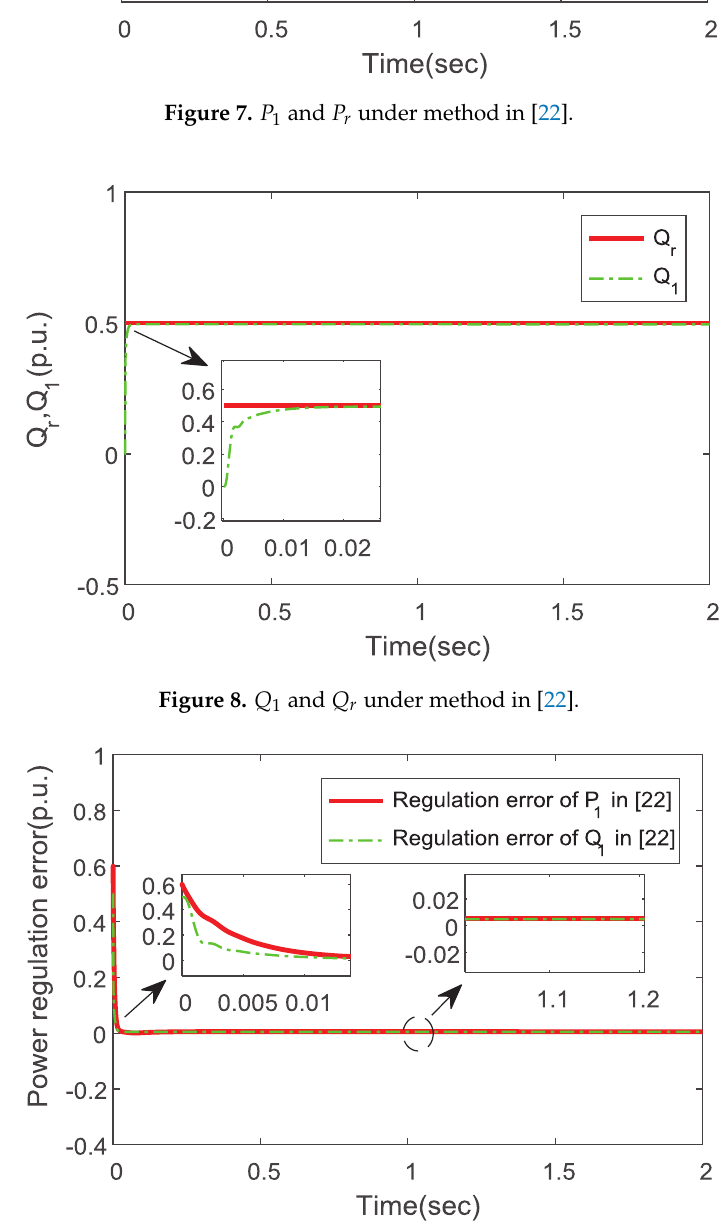
Figure 9. Tracking error of P 1 and Q 1 under method in